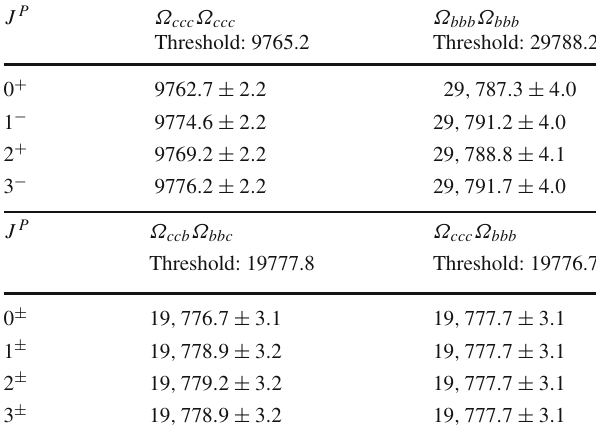
Table 3 The energy (in MeV) of the color-singlet channel for the fully heavy dibaryons